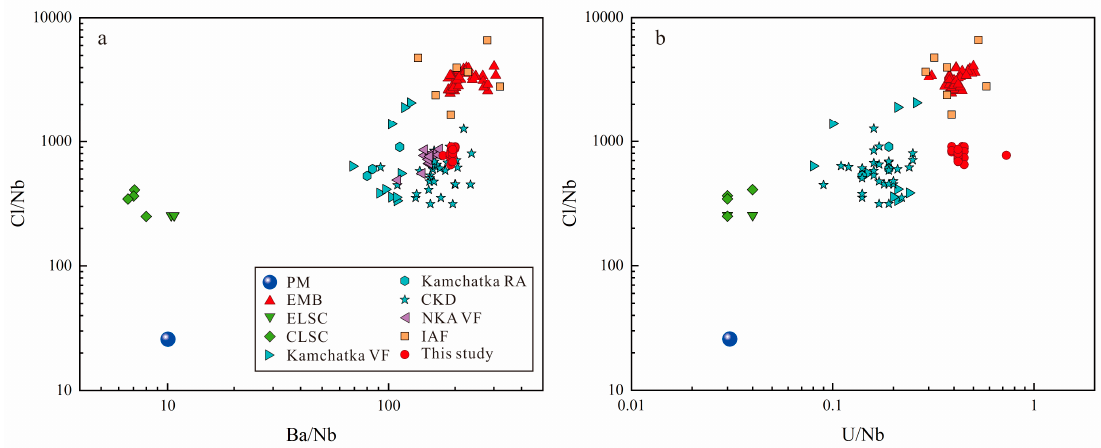
Figure 11. Plots of ( a ) Cl/Nb versus Ba/Nb and ( b ) Cl/Nb versus U/Nb in subduction-related volcanic rocks (data from: PM, Primitive Mantle [91]; EMB, Eastern Manus Basin [15]; ELSC, Eastern Lau Spreading Center [10,98]; CLSC, Central Lau Spreading Center [10,98]; Kamchatka VF, volcanic front of Kamchatka [99]; Kamchatka RA, rear-arc of Kamchatka [99]; CKD, The Central Kamchatka Depression [99]; NKA VF, volcanic front of Northern Kurile Arc [99]; IAF, Izu arc front